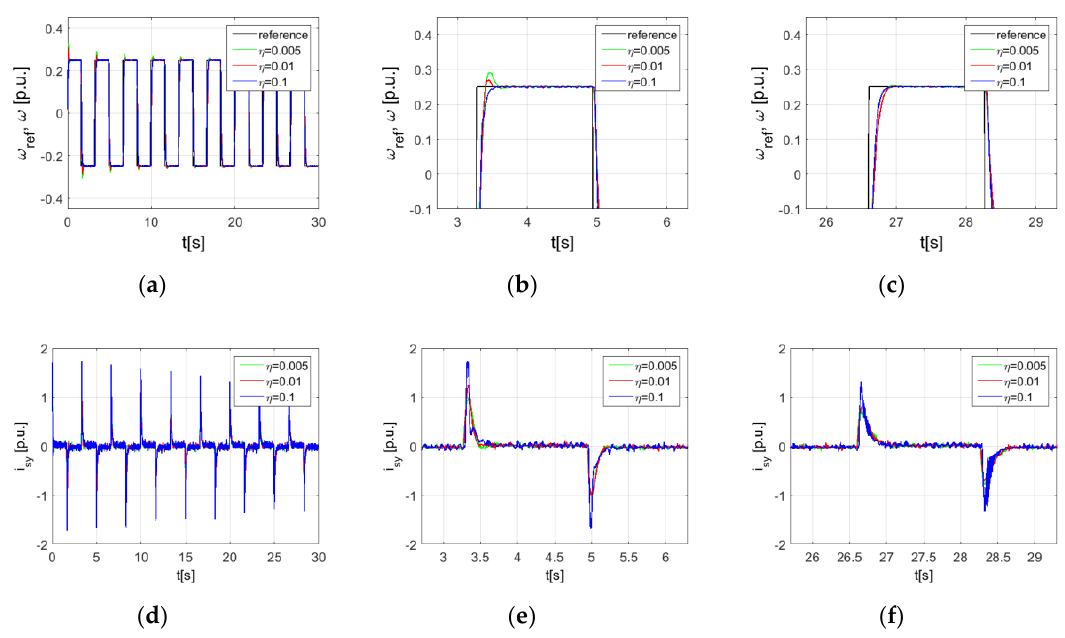
Figure 13. Transients of state variables—speed ( a – c ) and component of current ( d – f ) measured in the DFOC structure with PI speed controller and neural compensation: influence of training coefficient.